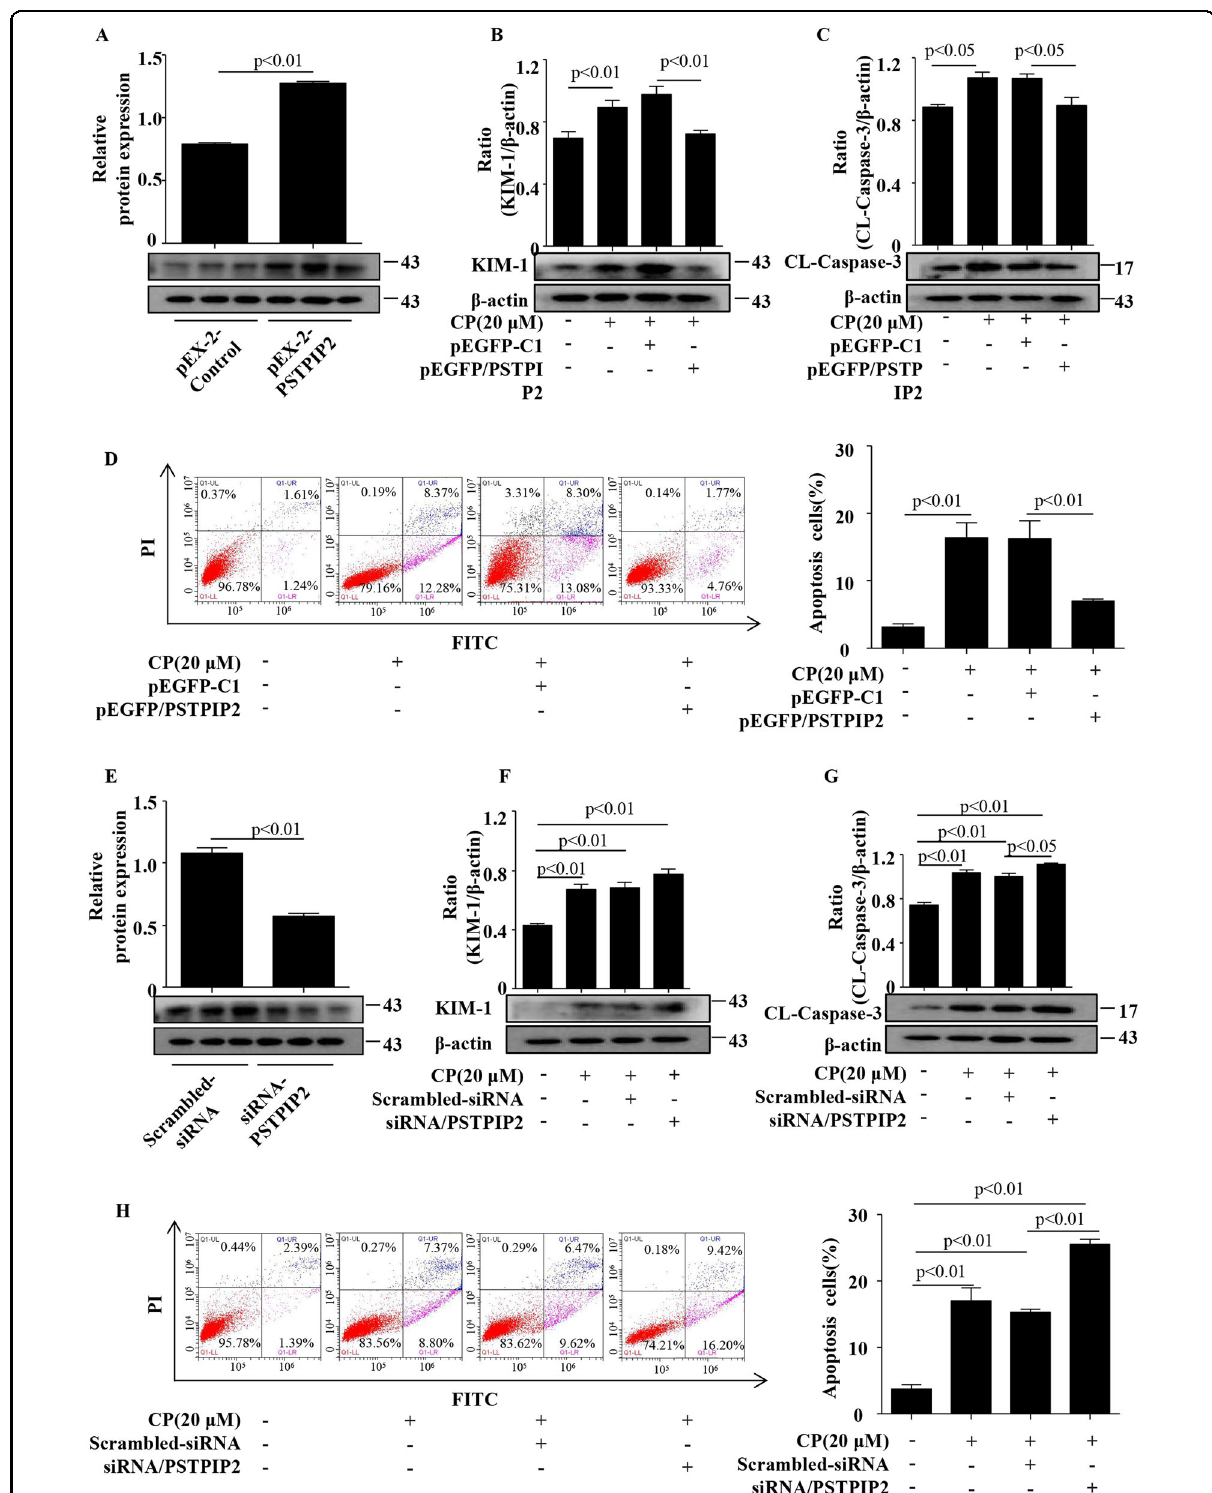
Fig. 5 PSTPIP2 inhibited apoptosis of renal tubular epithelial cells in vitro. a The ef fi ciency of PSTPIP2 overexpression in HK-2 cells detected by western blot. b Protein level of KIM-1 in HK-2 cells treated with pEX-2-PSTPIP2 analysed by western blot. c Protein level of cleaved caspase-3 in HK-2 cells treated with pEX-2-PSTPIP2 analysed by western blot. d Flow cytometry assay. e The ef fi ciency of PSTPIP2 knockdown in HK-2 cells detected by western blot. f Protein level of KIM-1 in HK-2 cells treated with siRNA-PSTPIP2 analysed by western blot. g Protein level of PSTPIP2 in HK-2 cells treated with siRNA-PSTPIP2 analysed by western blot. h Flow cytometry assay in various groups. Similar results were obtained in triplicate culture